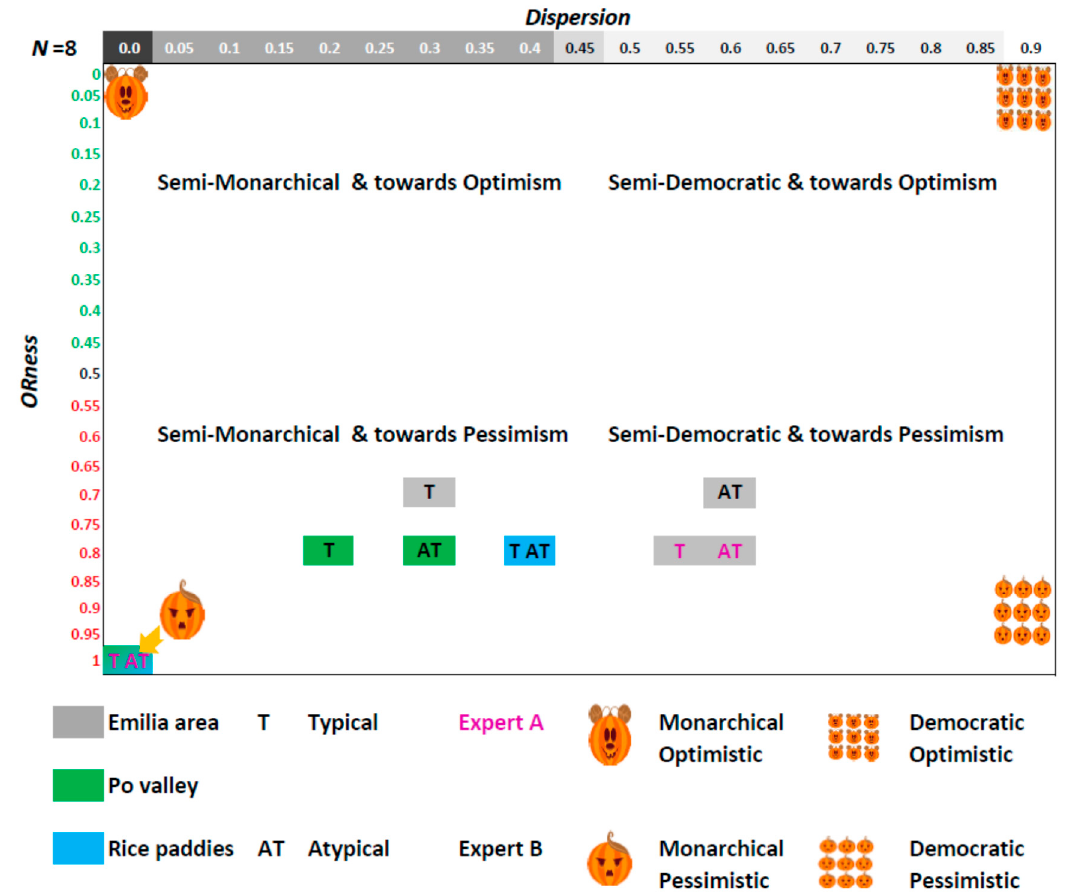
Figure 9. ORness–dispersion space in which the OWA operators learned in each ROI (identified by rectangles with distinct colors: grey in the Emilia area, green in the Po Valley and light-blue in the rice paddies) in the typical (T) and atypical (AT) validations for experts A (in violet) and B (in black) are positioned according to their ORness and dispersion measures.